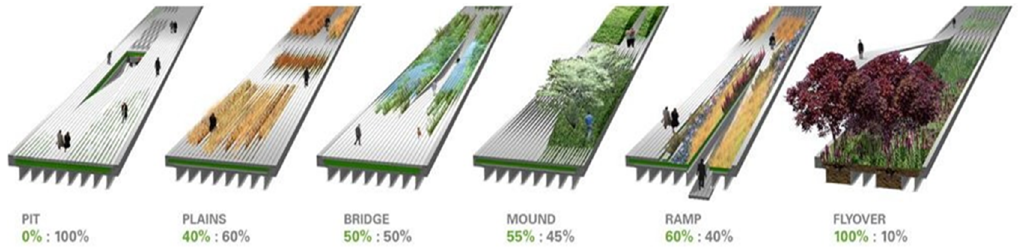
Figure 3. Design Proposal of the High Line. Reprinted from ref. [50].